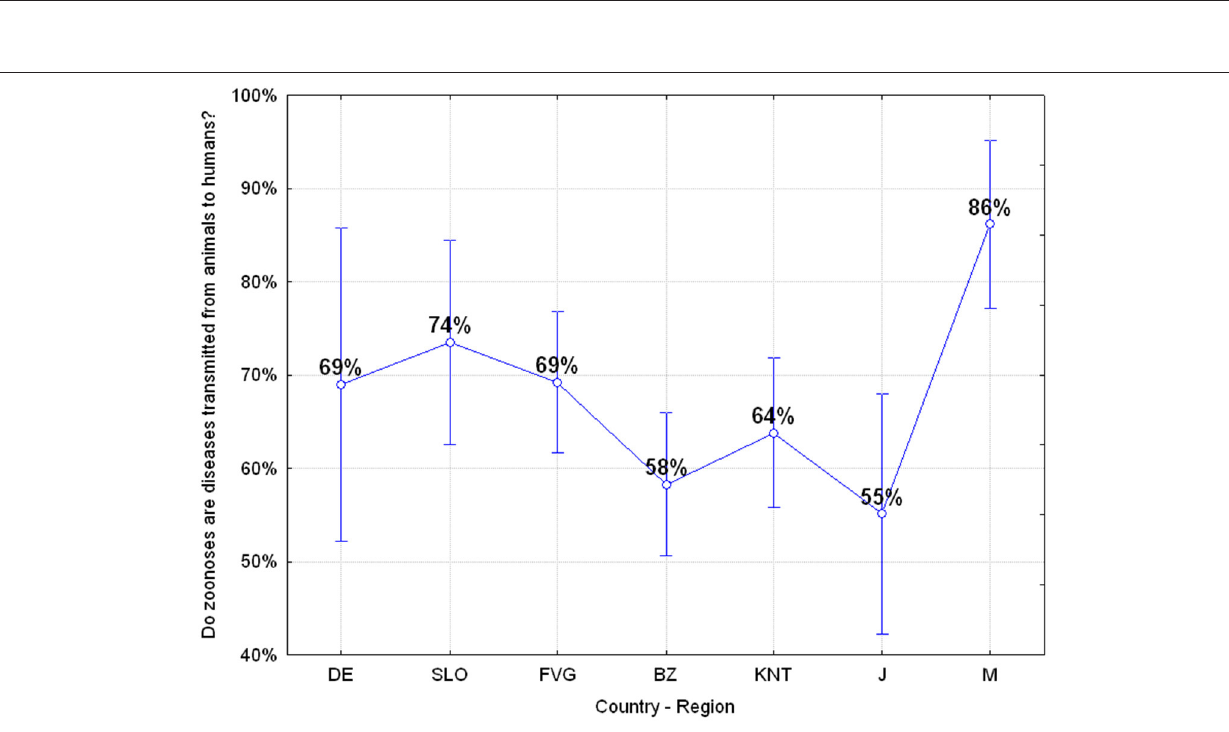
FIGURE 8 | Q22: “Many diseases that affect humans come from animals?” ANOVA F (6,649) p = 0.04374 [Axes X regions or countries, Axes Y % correct answers–DE, Germany; SLO, Slovenia; FVG, Friuli Venezia Giulia Italy; BZ, Autonomous Province of Bolzano Italy; KNT, Carinthia Austria; J, Japan; M, Mauritius–( n = 656)].